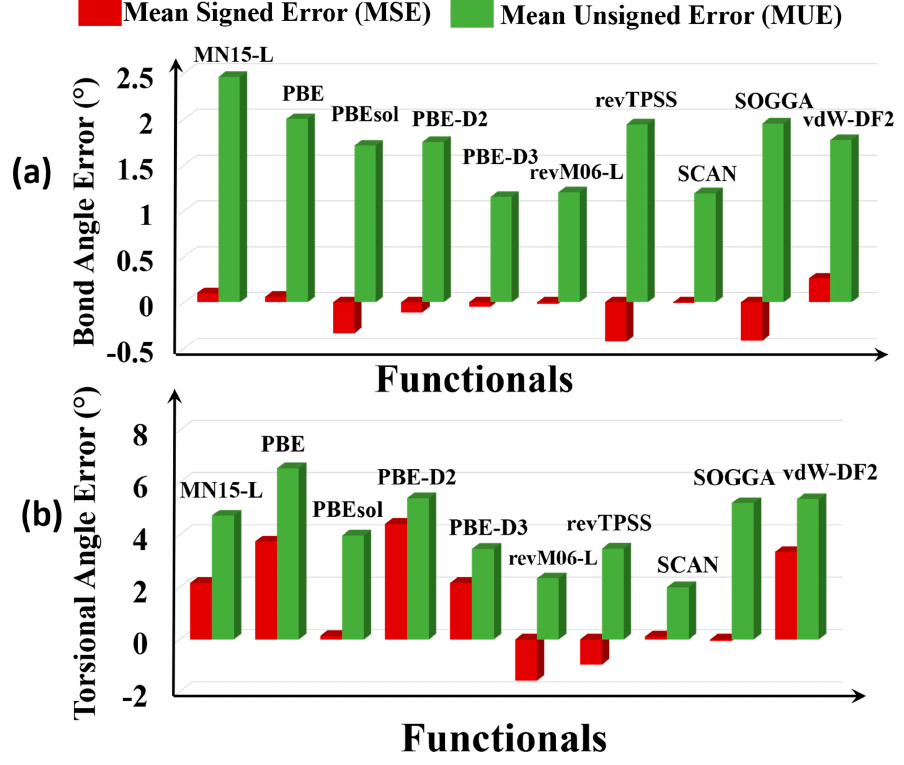
Figure 5. Errors of ( a ) bond angles and ( b ) torsional angles.